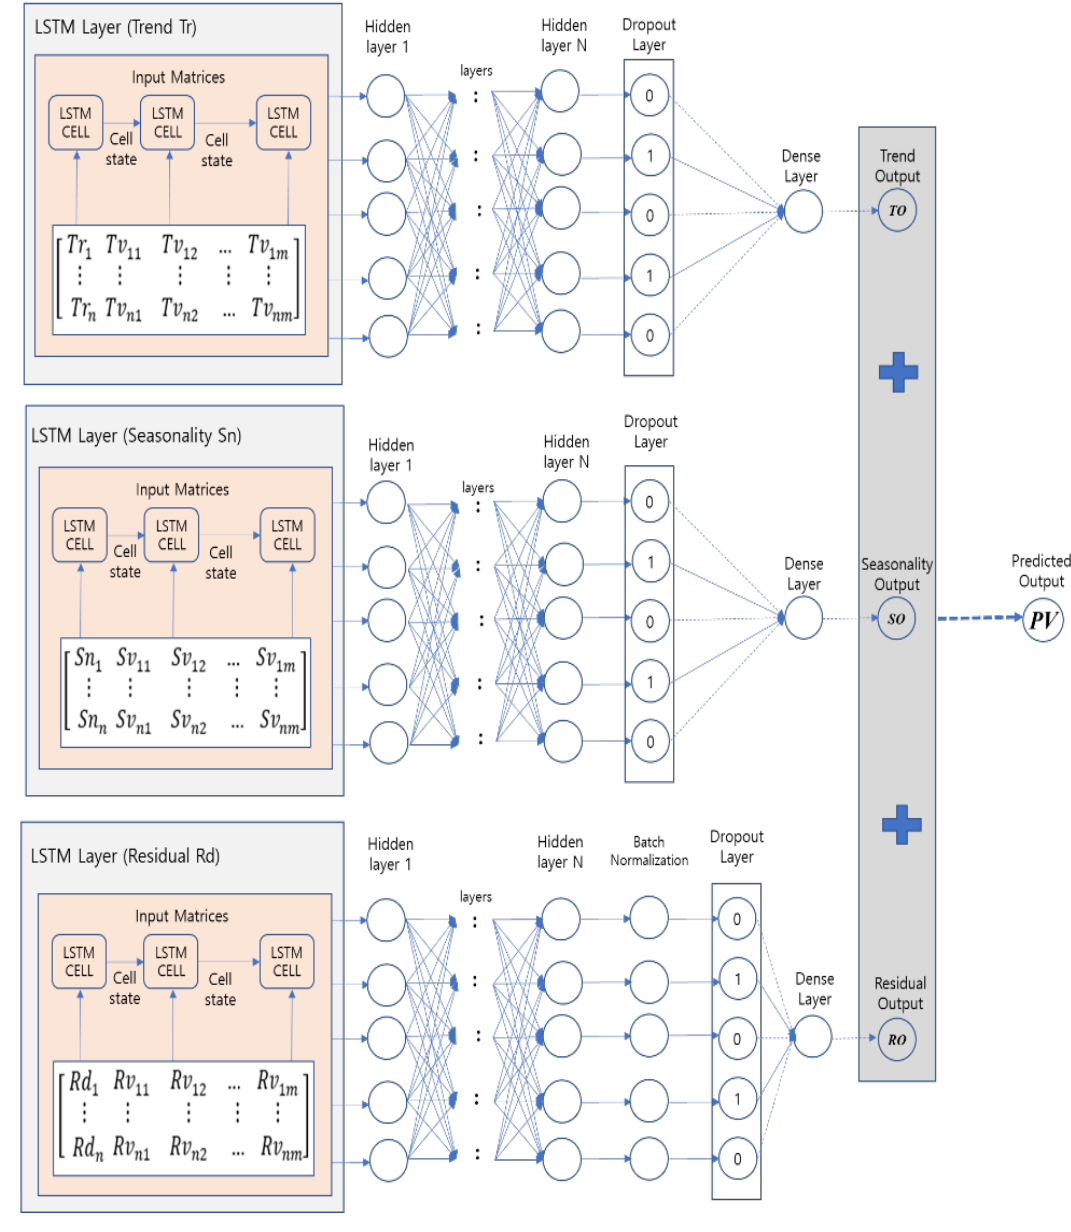
Figure 7. Long short-term memory architecture for time-series decomposition. To assess the performance of the proposed model and compare it with other meth- ods, MAE and root mean squared error (RMSE), which are denoted in Equations (17) and (18), are used.